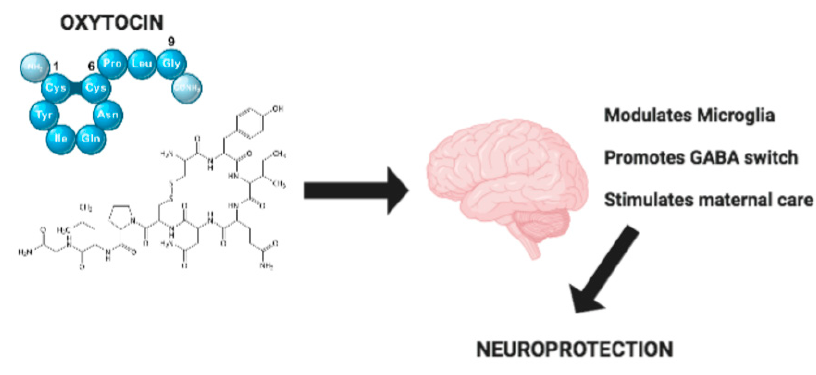
Figure 1. Mechanisms of Oxytocin neuroprotection.